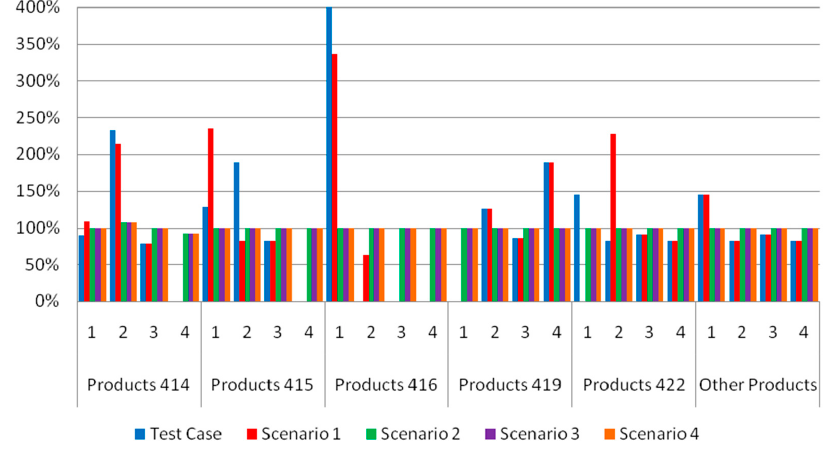
Figure Figure 9. Scenarios performance in relation to weekly demand, presented preliminarily in Reference [23].